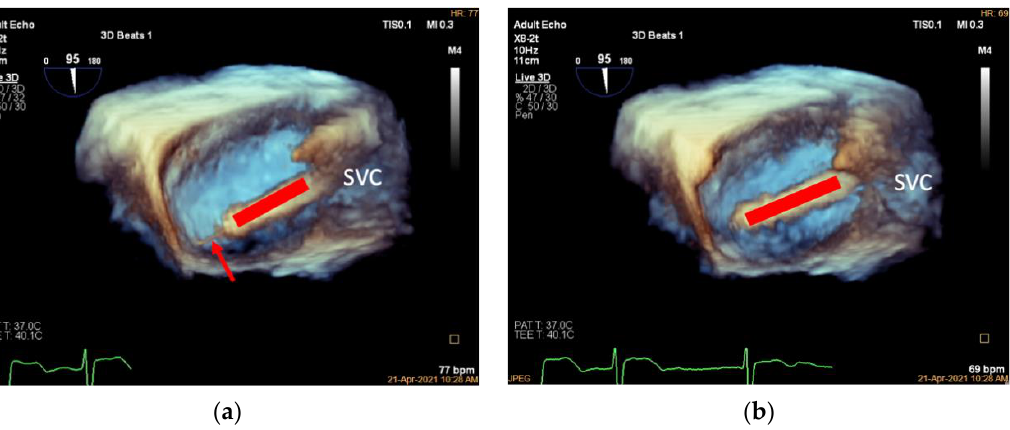
Figure 4. Advancing the guide sheath. ( a ): Three-dimensional mid-esophageal bicaval view, the guide sheath (red line) slowly advancing along the guidewire (red arrow) to the lower third of the right atrium at about 1 cm from the inferior vena cava; ( b ): the same view showing the guide sheath after withdrawing the Super Stiff guidewire (red line). SVC, superior vena cava.